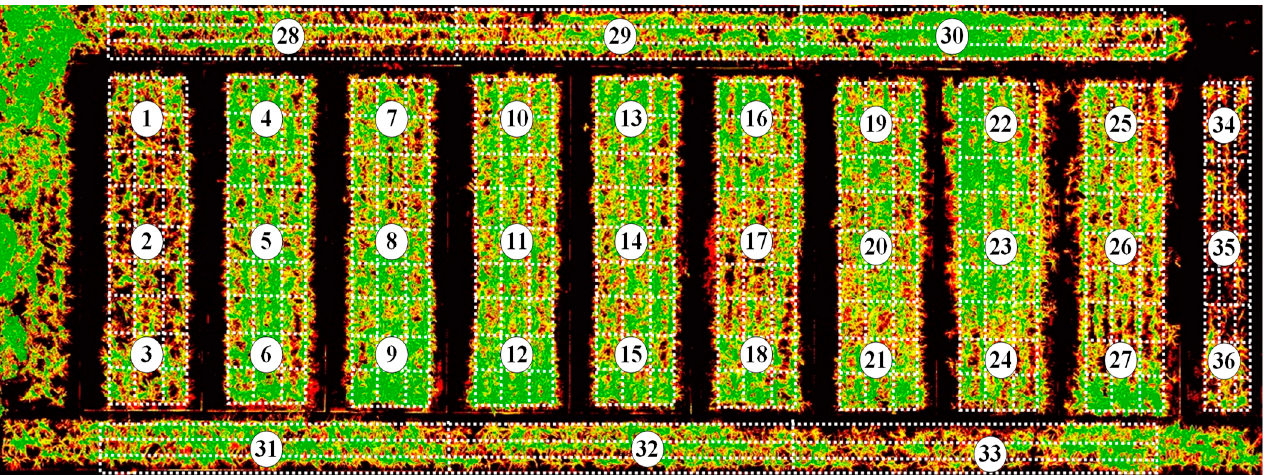
Figure 5. NDVI image of the extracted canopy. The 36 white circled numbers represent 36 sampling areas, each sampling area was further divided into nine grids as shown by the white dashed lines.